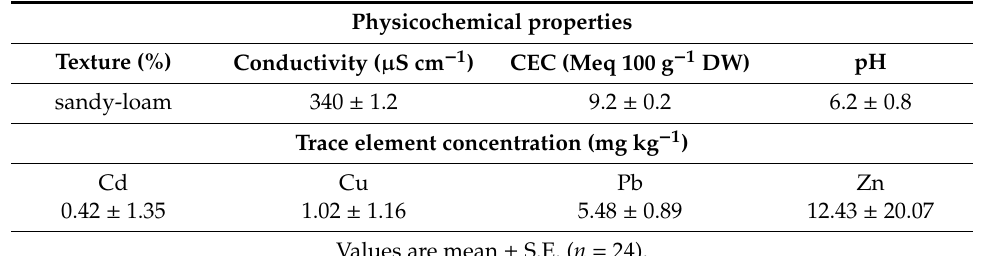
Table 1. Physicochemical properties and total cadmium (Cd), copper (Cu), lead (Pb), and zinc (Zn) concentrations of the military soil used in the microcosms